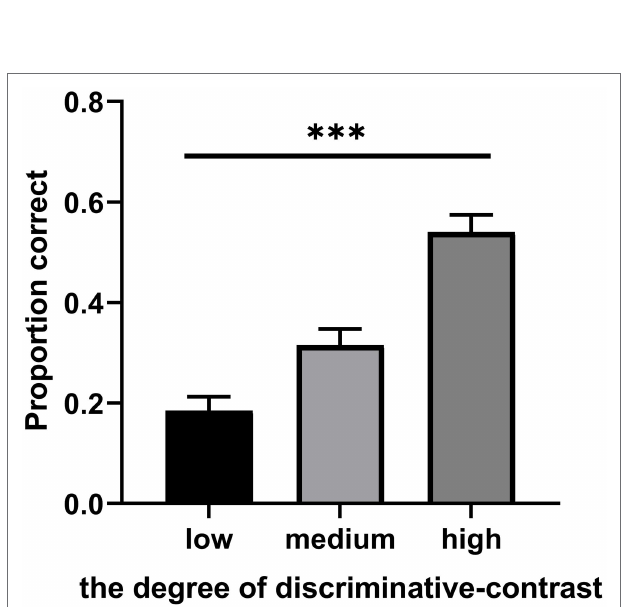
FIGURE 7 | Mean test performance as a function of the degree of discriminative-contrast in Experiment 3. Error bars represent SEM. *** p <